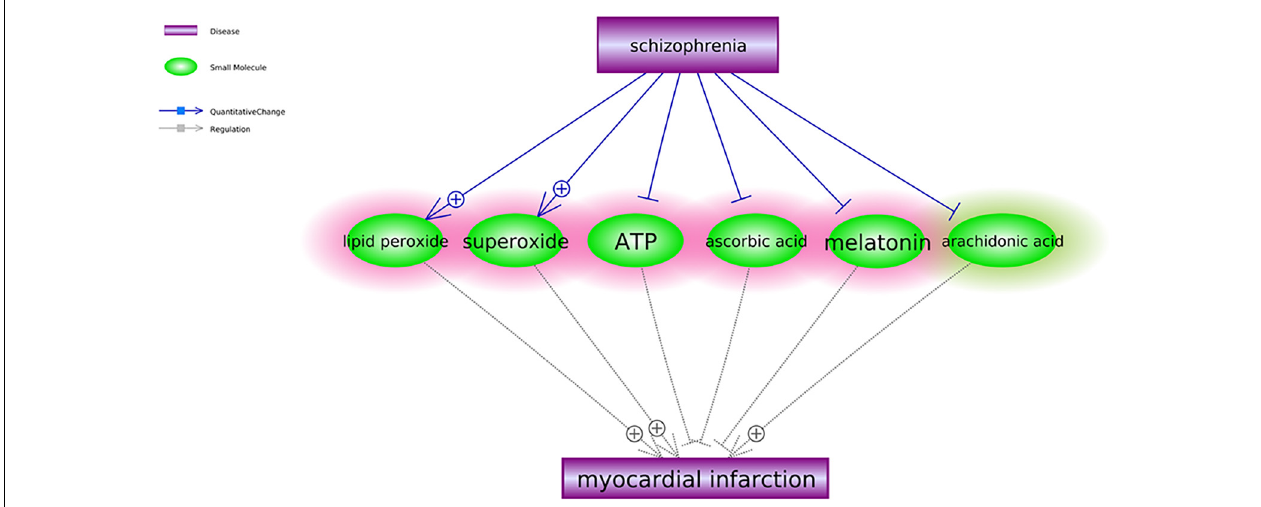
FIGURE 2 | Schizophrenia-driven small molecular regulators of myocardial infarction. Each relationship was supported by three or more references. The network contains two different types of relationships (edges): quantitative change and regulation. The small molecules highlighted in red were the regulators of myocardial infarction driven by schizophrenia to play antagonistic roles in the development and progression of myocardial infarction. The ones in green play antagonistic roles in the development and progression of myocardial infarction.